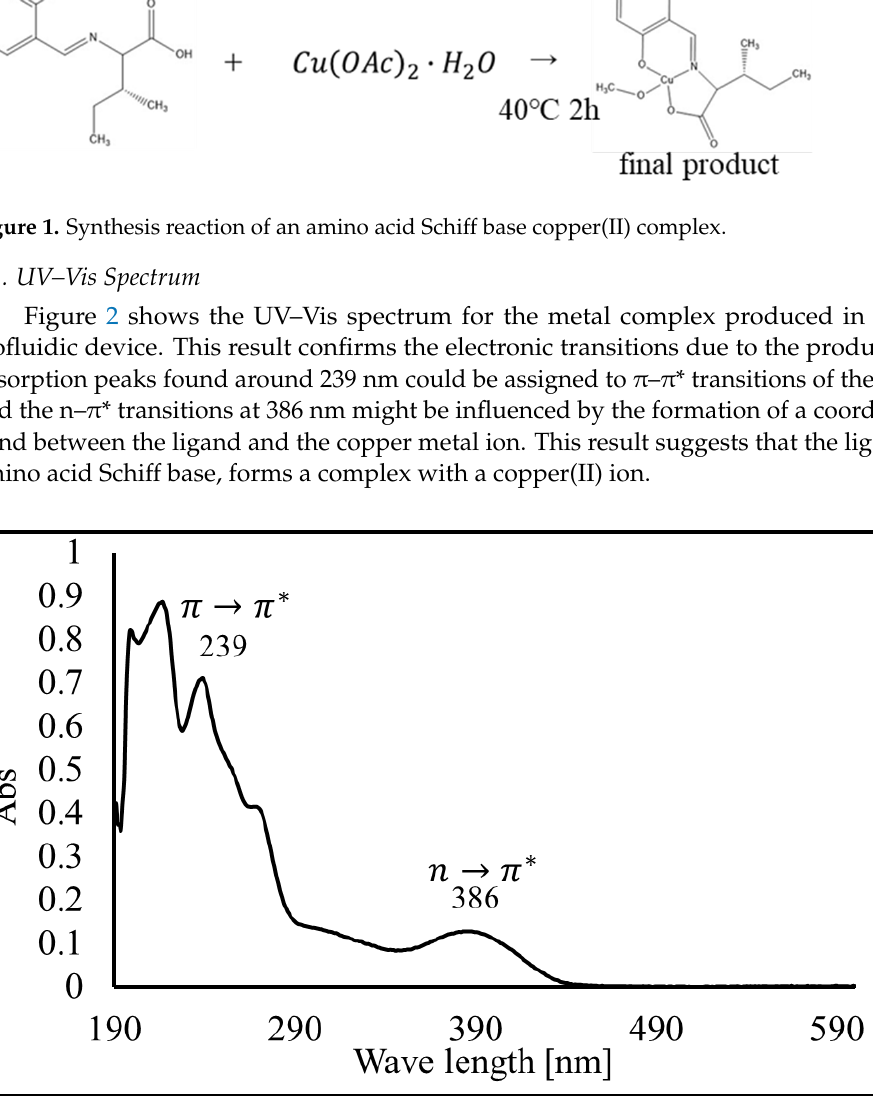
Figure 2. UV– Vis spectrum of an amino acid Schiff base copper(II) complex.